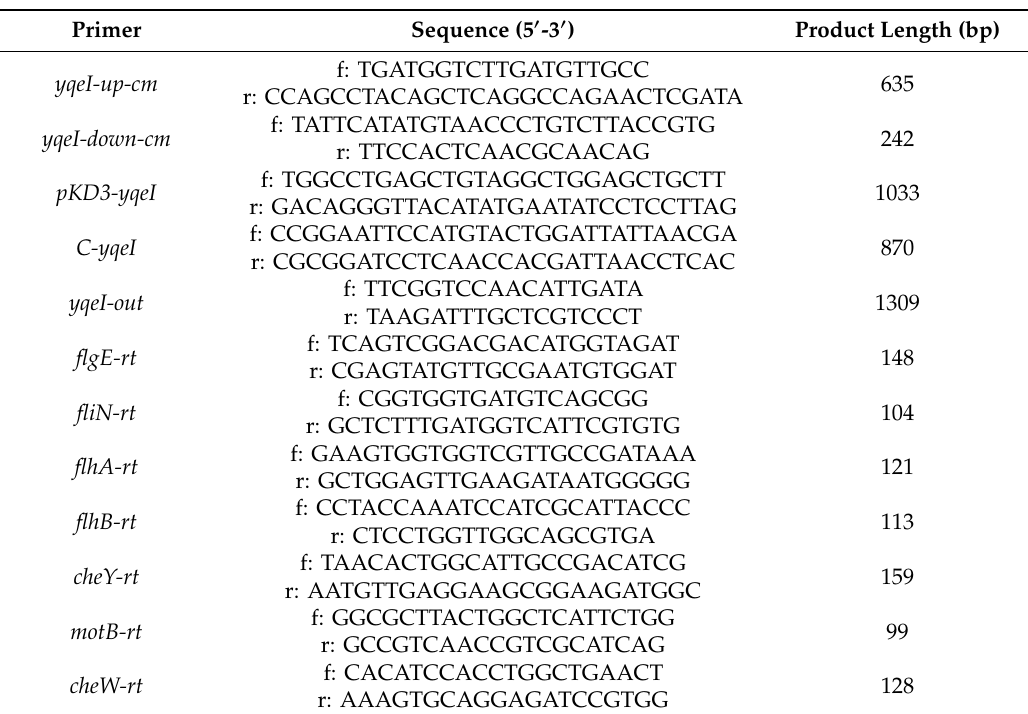
Table 2. Primer used in